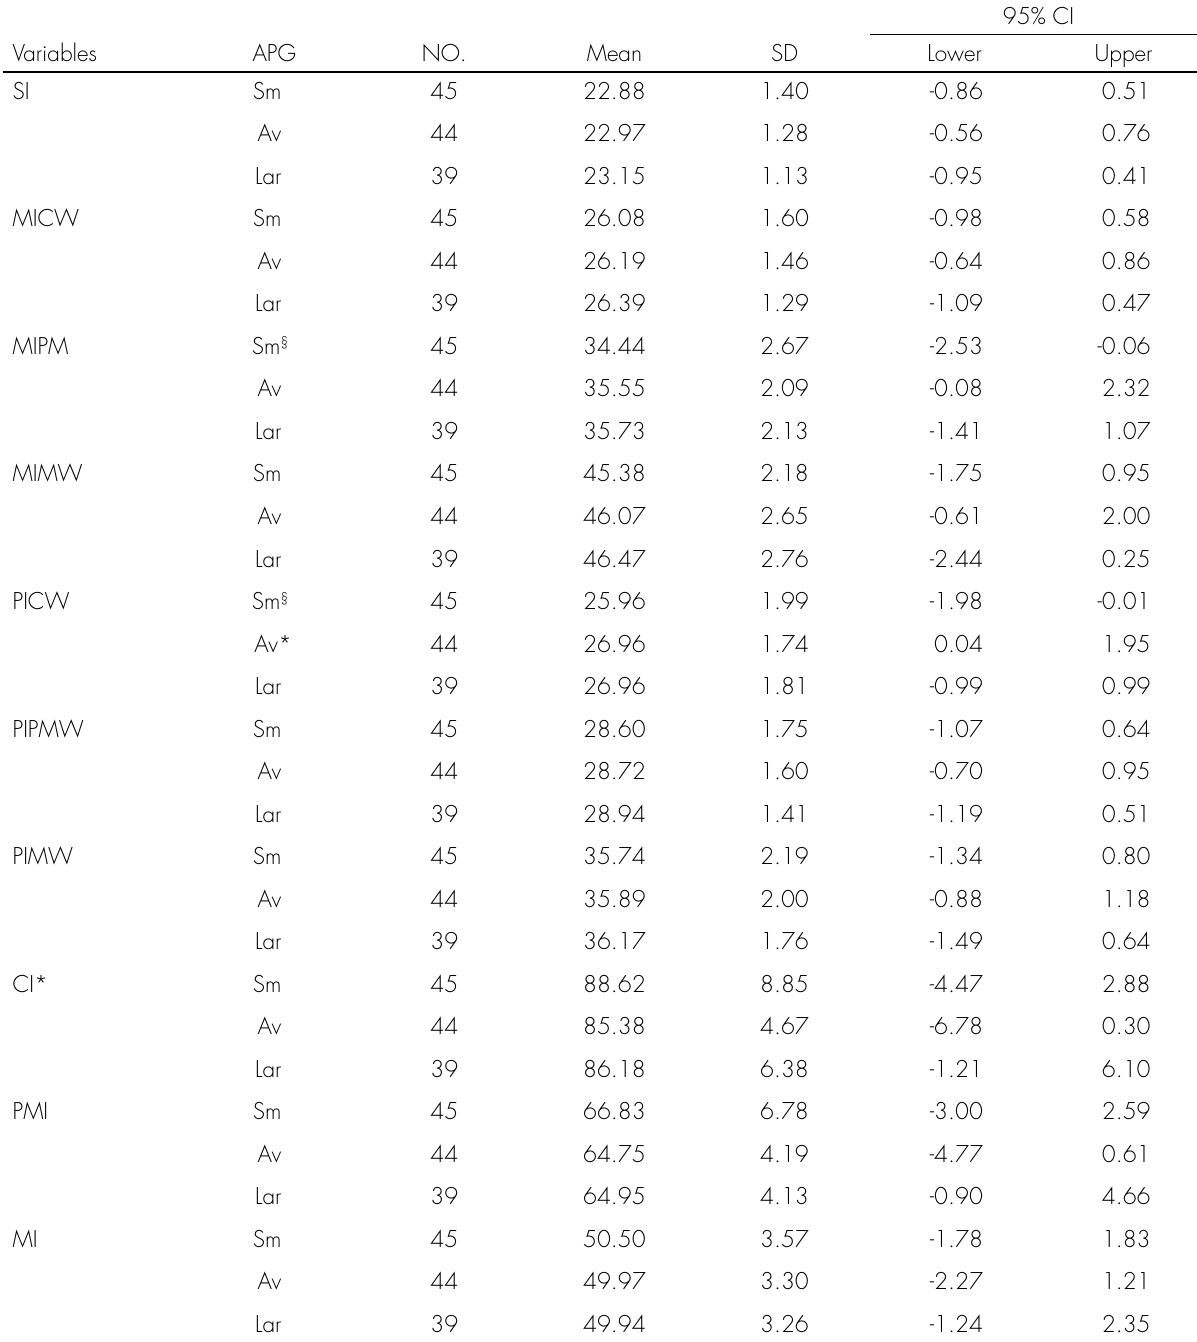
Table VI. Comparison of the sum of the incisors, arch width and expansion indices in relation to various arch perimeter groups (APG) of the mandibular